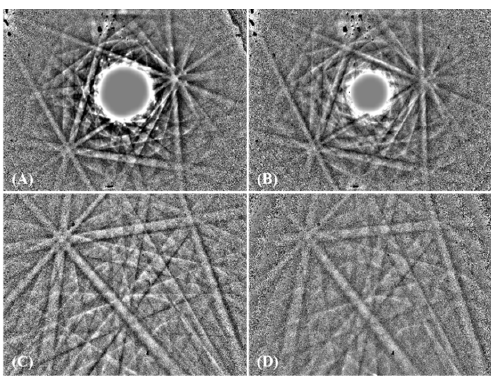
Figure 4. Kikuchi patterns at the accelerating voltage of 30 kV and thicknesses of ( A , C ) 91 and ( B , D ) 169 nm for the on-axis and off-axis TKDs, respectively. These two samples are presented because the difference in their thickness is larger.